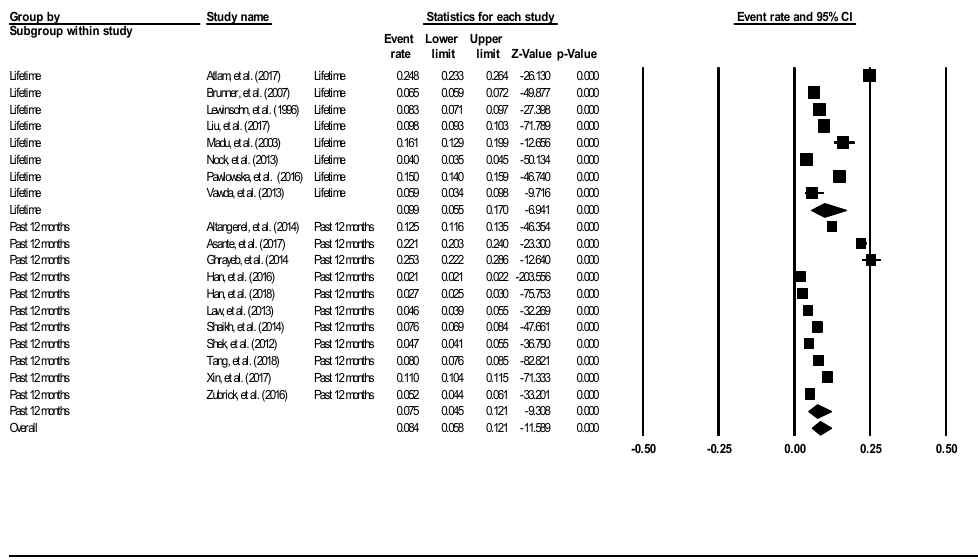
Figure 4. Forest plot of the aggregate lifetime and 12-month prevalence of suicidal plans.